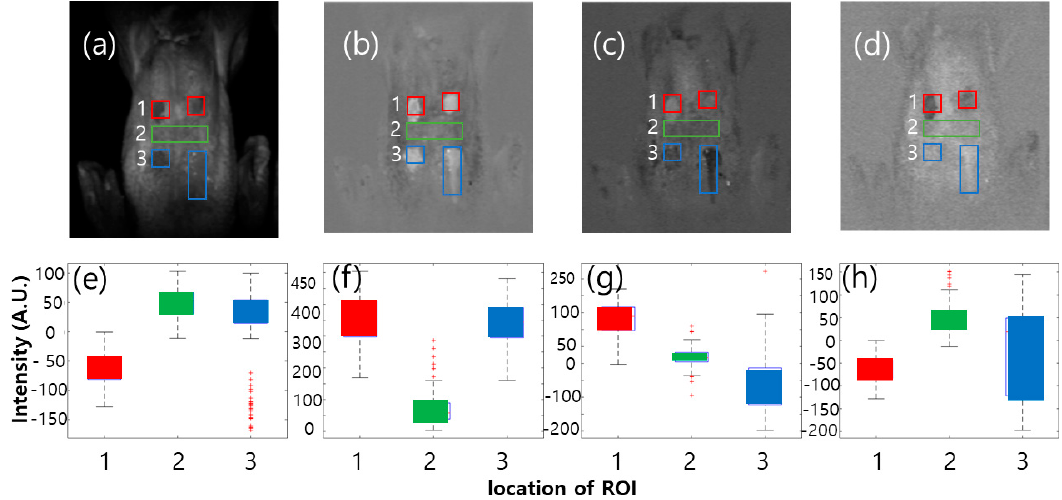
Figure 9. PC images of on-line scan multispectral fluorescence imaging (MFI) images for chicken with fecal spots. PC images ( a – d ) and four boxplots ( e – h ) collected pixels from red (1), green (2), and blue (3) rectangles.